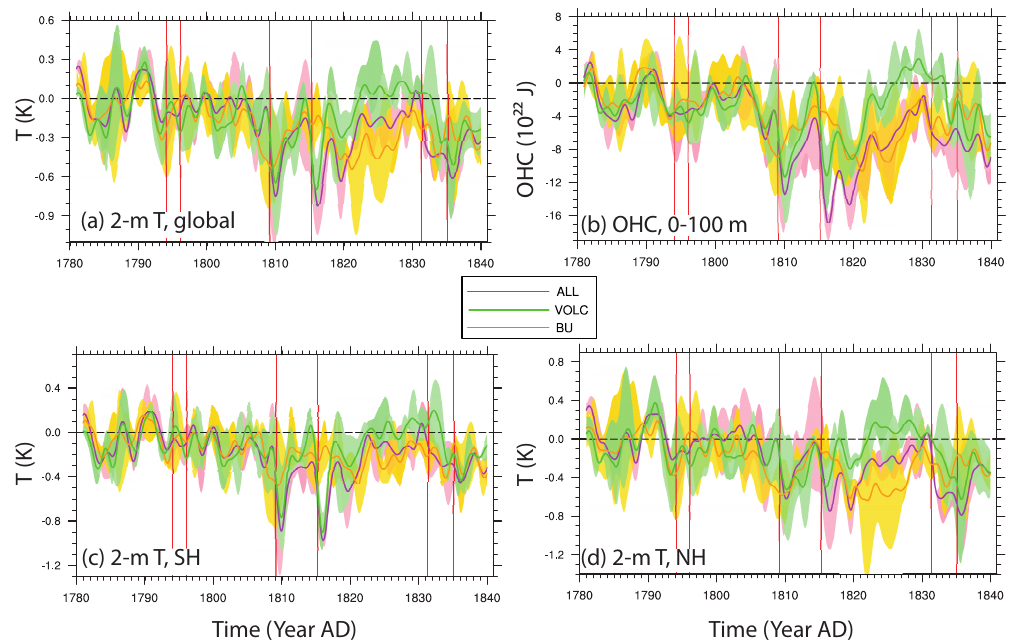
Fig. 4. (a) Ensemble means of detrended anomalies of experiments ALL, VOLC and BU relative to CTRL1780 for (a) global 2m tempera- tures; (b) global ocean heat content (OHC) of the upper ocean (first 100m in depth); (c) SH 2m temperatures; (d) NH 2m temperatures. For all experiments, the envelope shows the min/max values. Red vertical lines highlight the years in which a volcanic eruption